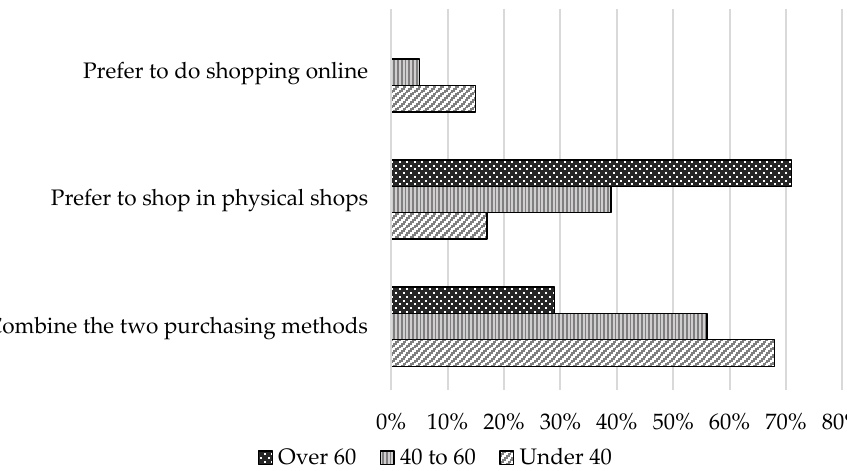
Figure 19. Consumer habits in the RMSC after COVID-19.